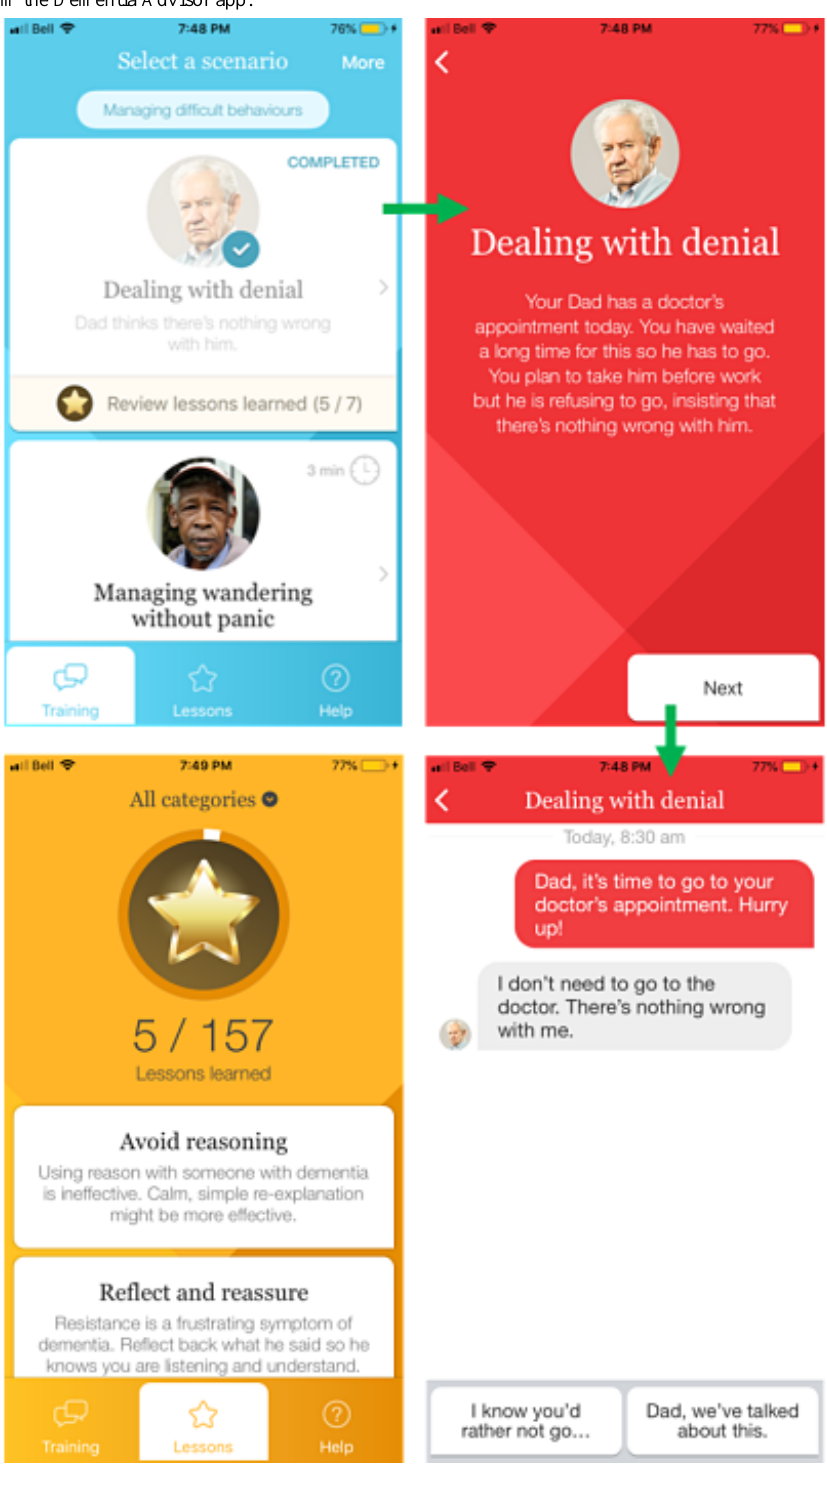
Figure 2. Screenshots from the Dementia Advisor